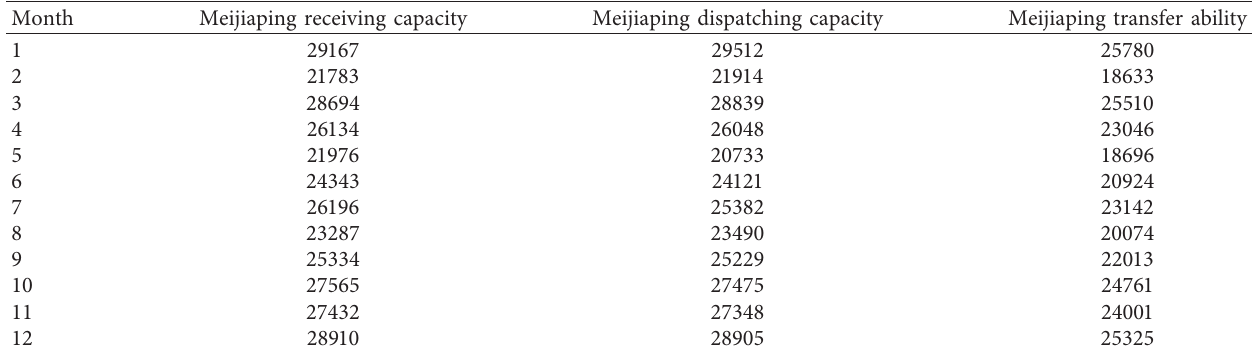
Table 2: Initial statistics of the “transportation” system of the Tongchuan Depot in